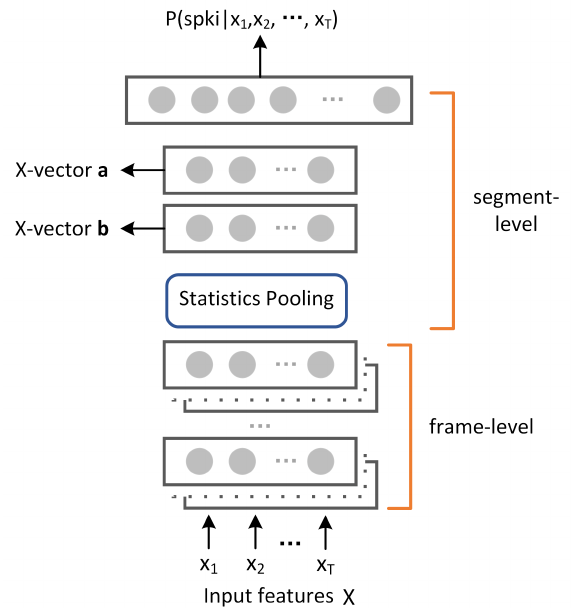
Figure 4. Diagram of the X-vector